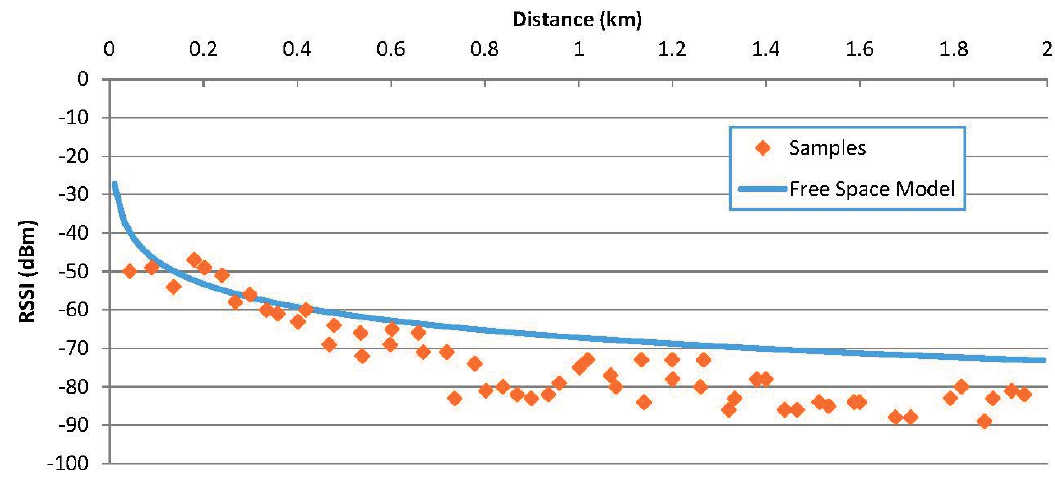
Figure 14. Received RSSI in a real